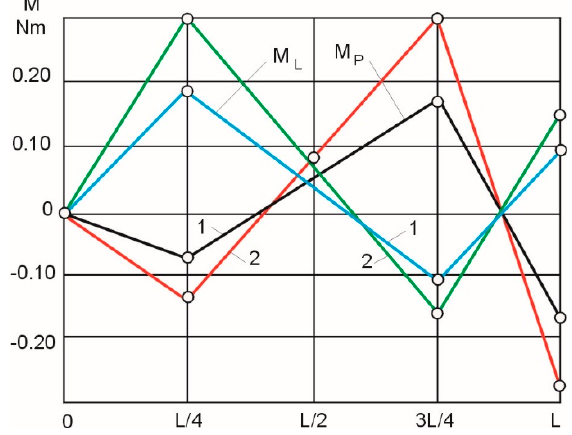
Figure 7. Linearized values of the control moments on the left (Ml) and right (Mp) stops: 1—for samples with d = 8 mm; 2—for samples with d = 14 mm. When the control of the bending moments was linearized in accordance with Figure 7, the actual experimental shape deviations of the samples with a diameter of 8 mm (curve 1) and 14 mm (curve 2) were as shown in Figure 8.